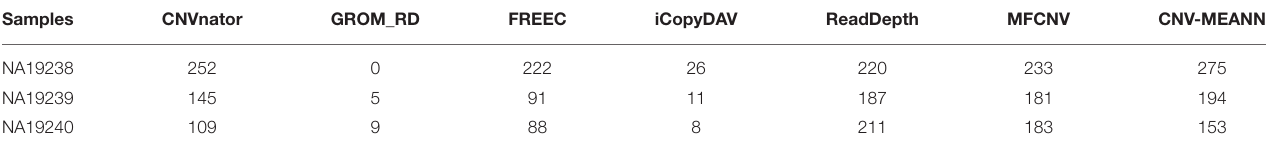
TABLE 3 | Number of CNVs detected by CNV-MEANN and the six peer methods on real sequencing samples.